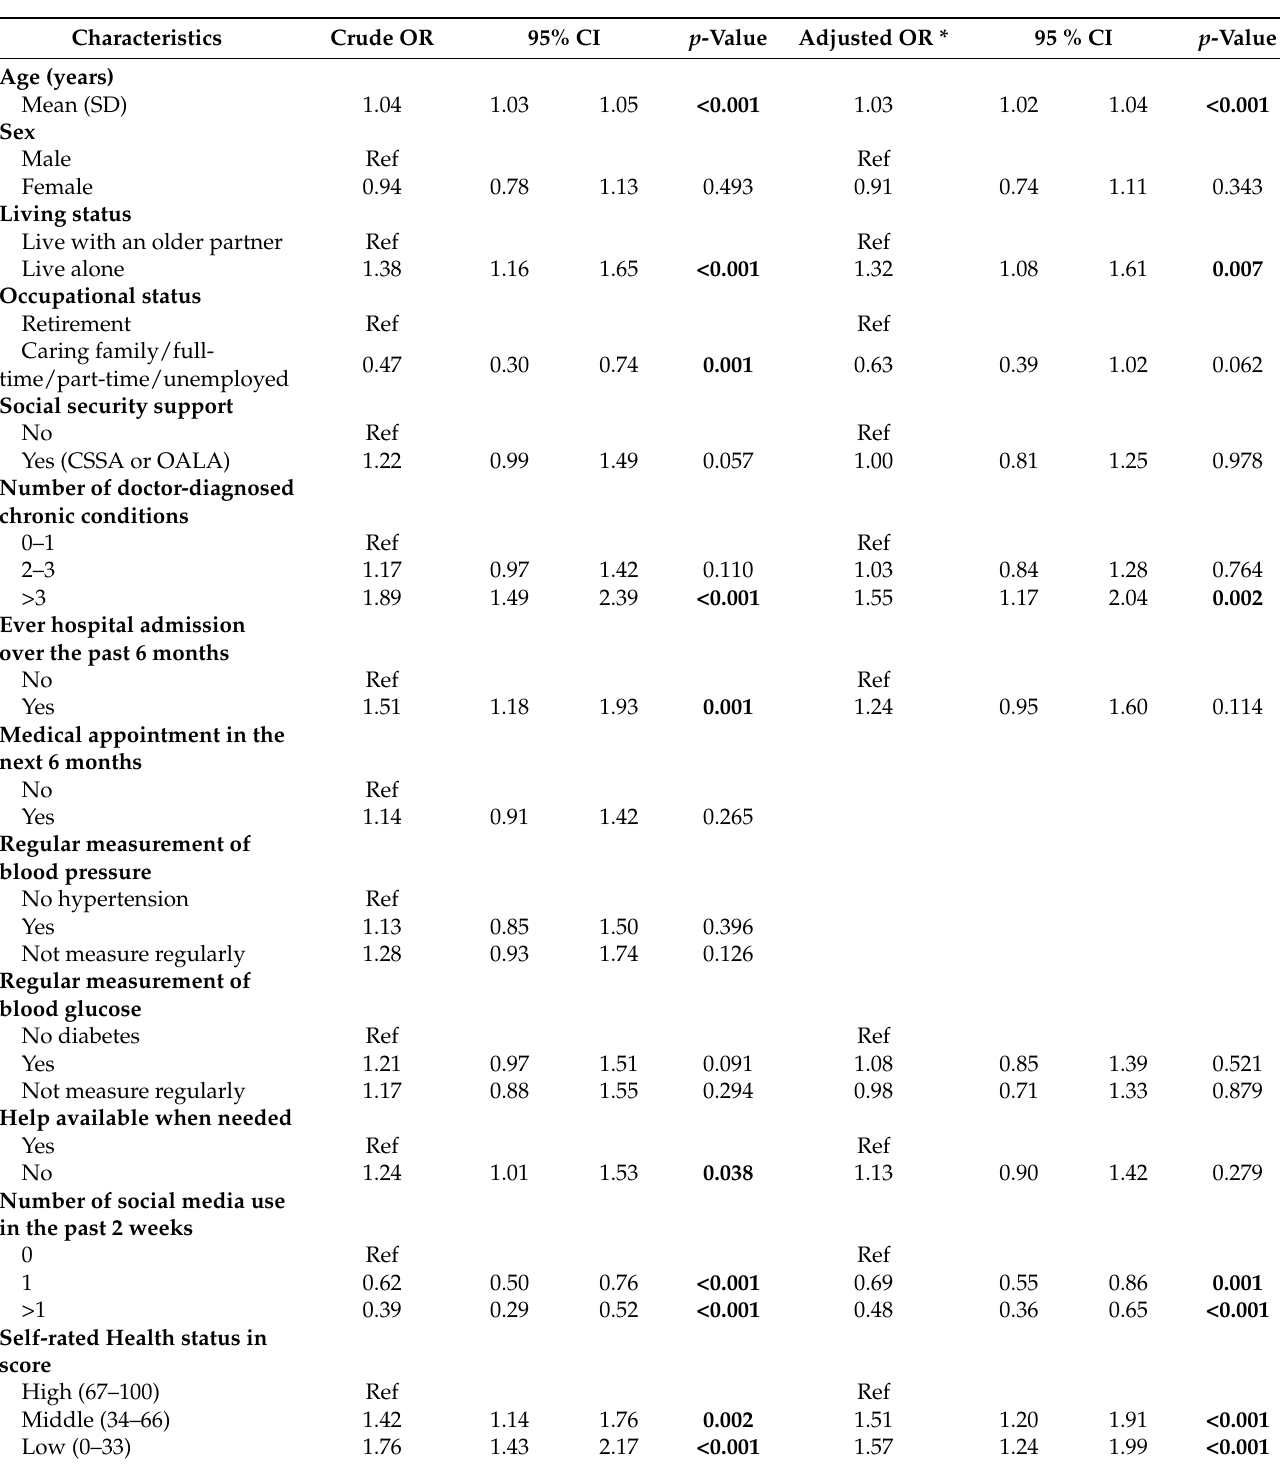
Table 2. Univariate (crude OR) and multivariate (adjusted OR) analyses on factors associated with COVID-19 vaccine reluctance and hesitancy to be vaccinated (N = 2109) (95% CI: 95% confidence